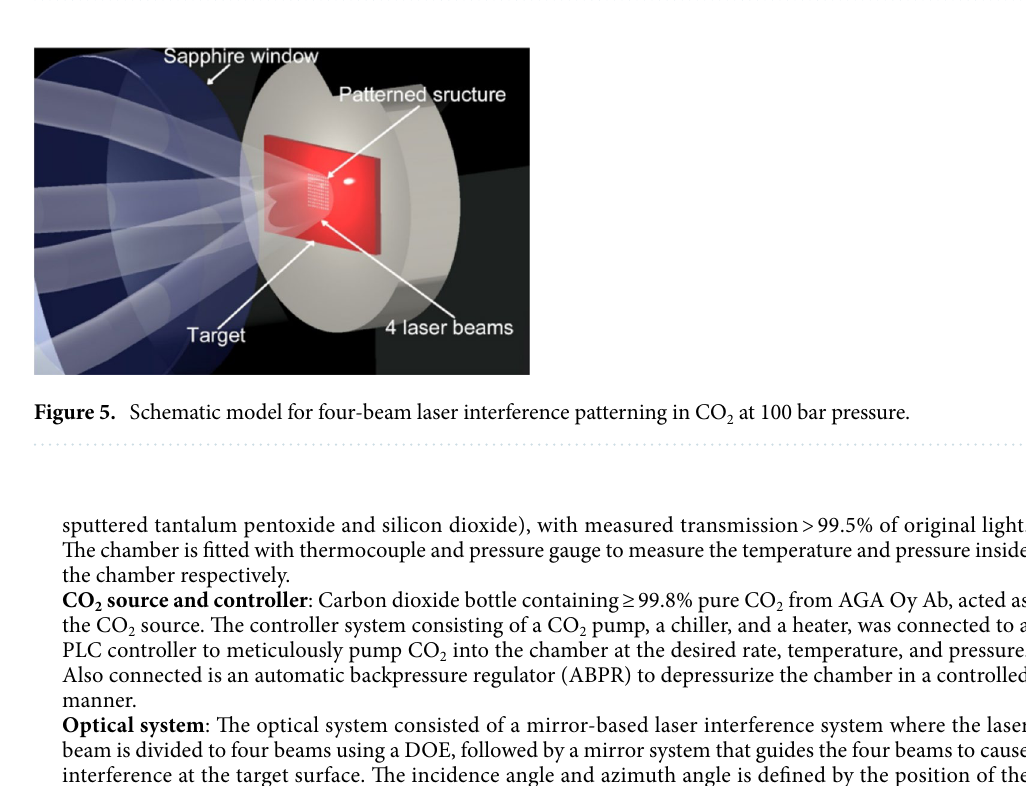
Figure 4. Schematic of experimental setup for direct laser interference patterning in high pressure CO 2 .